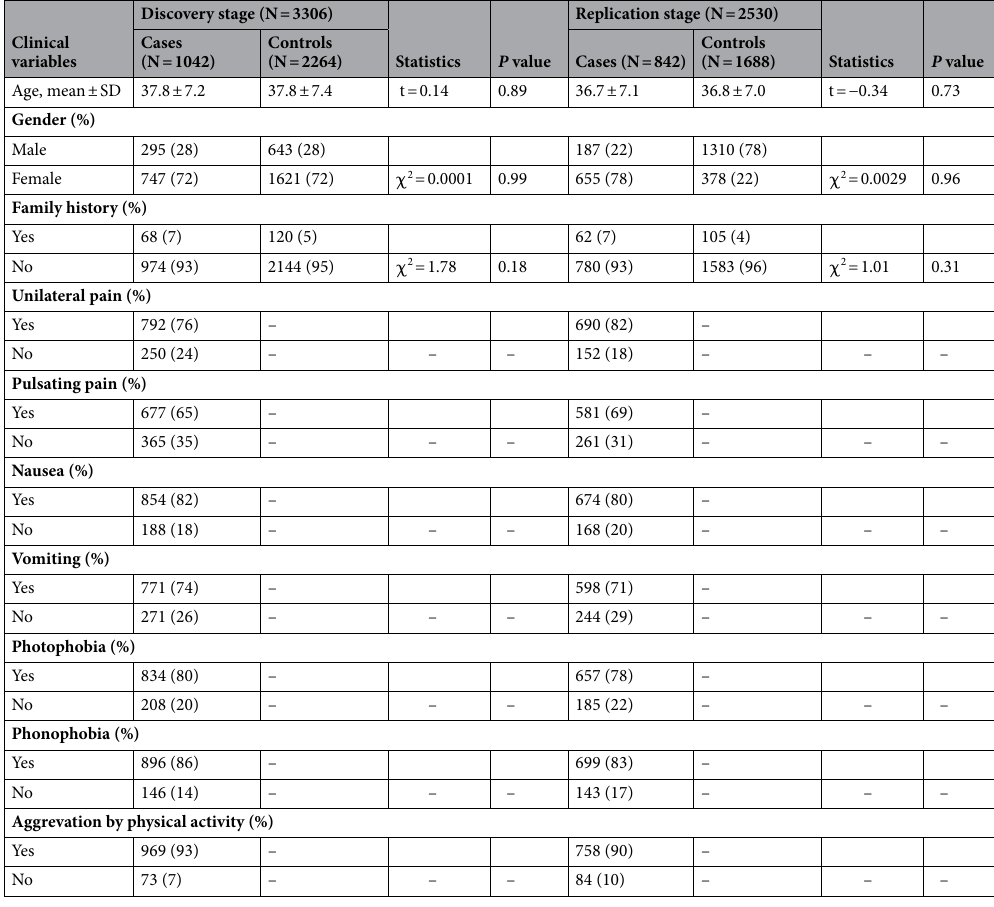
Table 1. Demographic and clinical information of the study